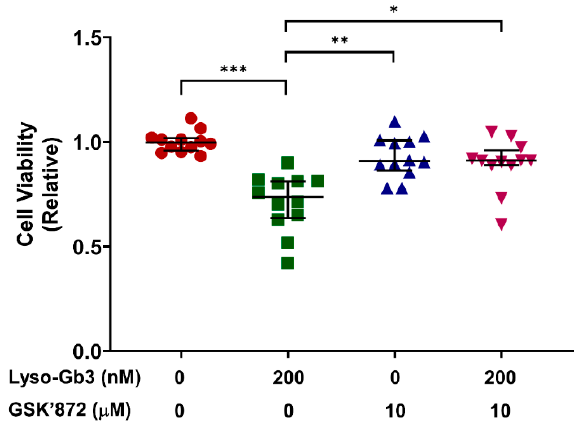
Figure 4. Cell viability after treatment with lyso-Gb3, GSK’872, or both. The leftmost group is the control group (neither lyso-Gb3 nor GSK’872). Each group was compared with every other group. Lyso-Gb3 (200 nM) treatment decreased cell viability. Cell viability improved after GSK’872 (10 μ M) treatment ( N = 12, median with interquartile range). * p < 0.05, ** p < 0.01, *** p < 0.001, by Kruskal-Wallis with Dunn’s post-hoc analysis.